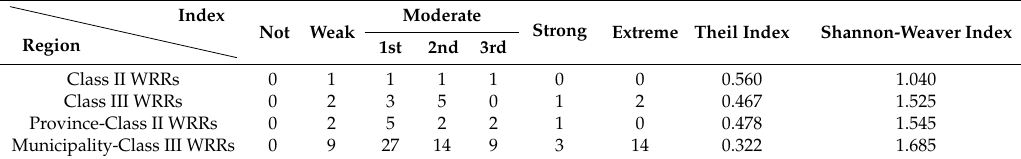
Table 3. Diversity and heterogeneity of water resource